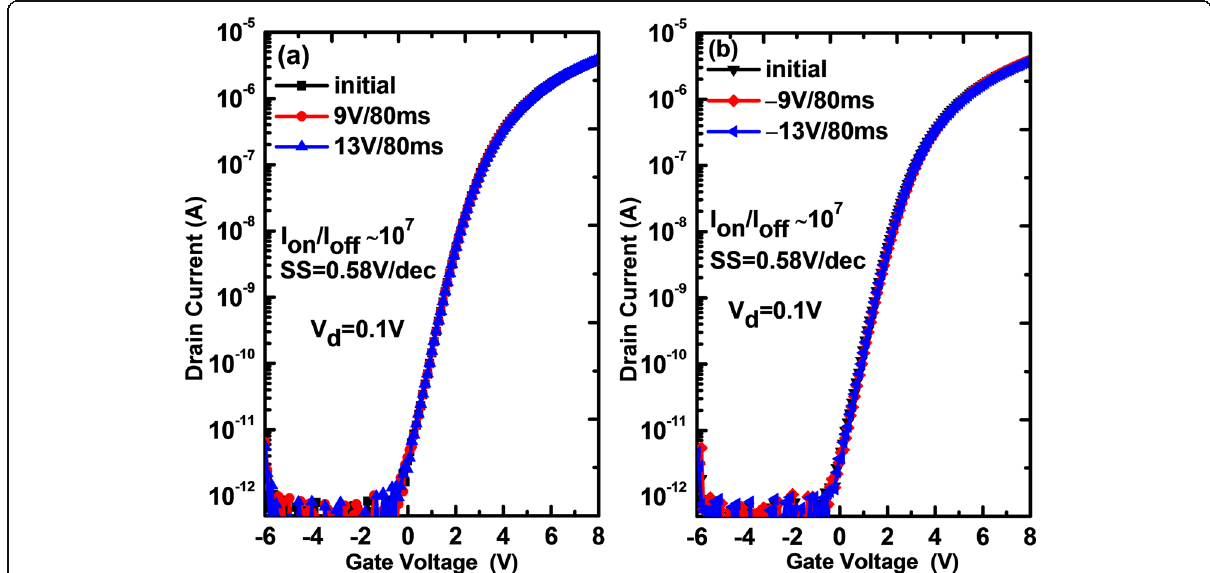
Fig. 3 The transfer curves of the a-IGZO TFT device and those programmed a at different positive gate biases for a constant time of 80 ms and b at different negative gate biases for a constant time of 80